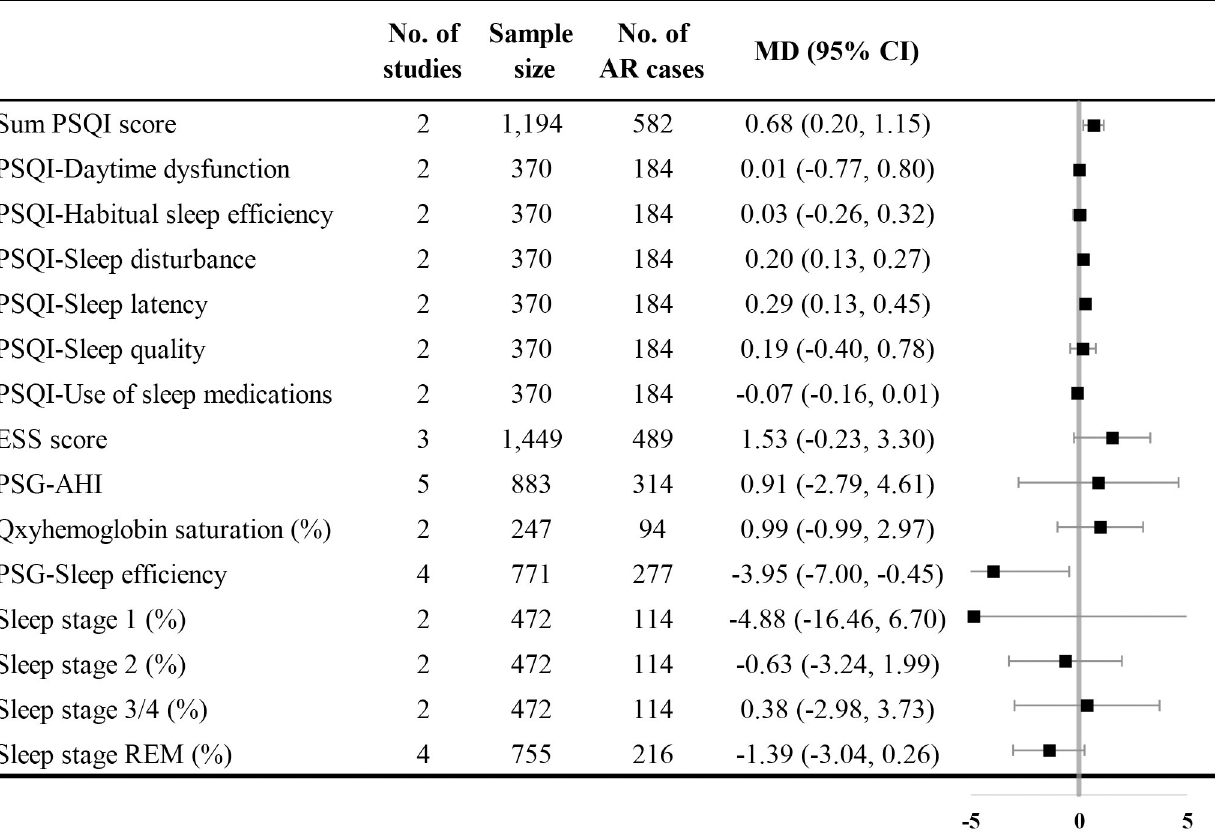
PLOS ONE | https://doi.org/10.1371/journal.pone.0228533 February 13,